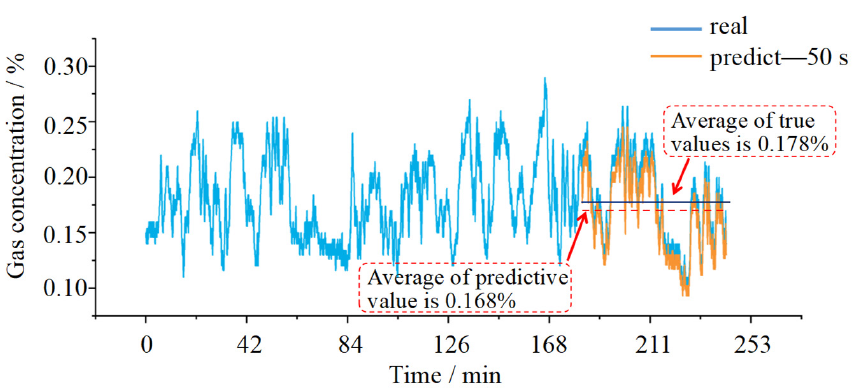
Figure 10. Gas concentration prediction of the model with an update period of 50 s.